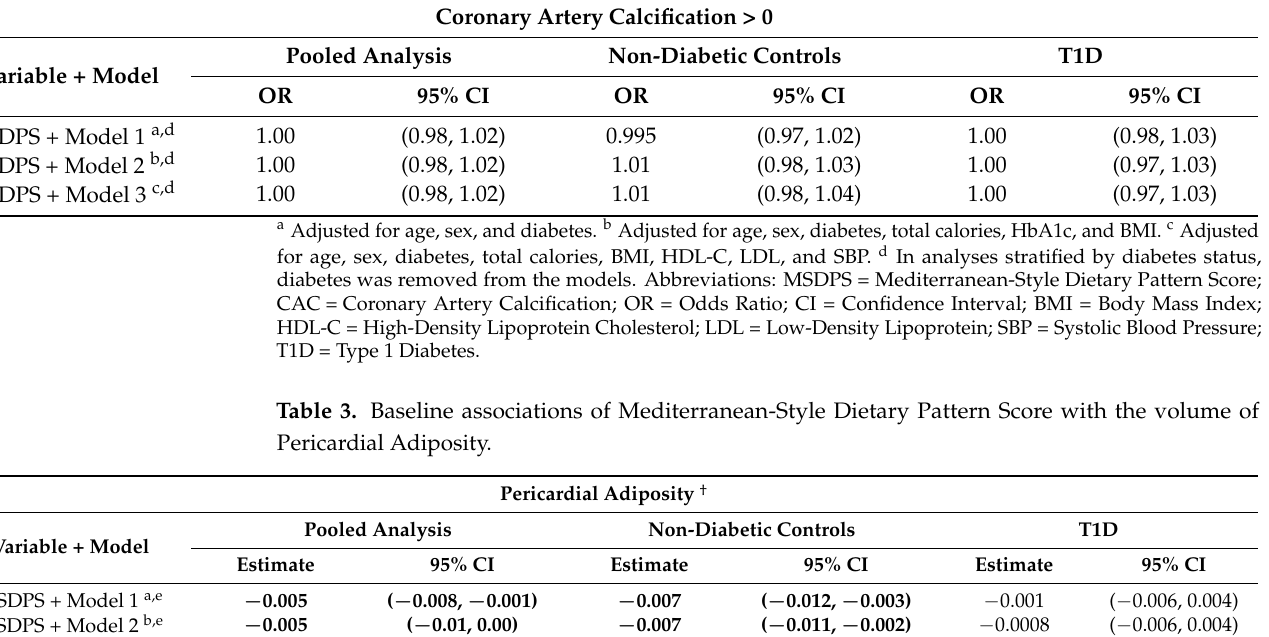
Table 2. Baseline associations of Mediterranean-Style Dietary Pattern Score with the presence of Coronary Artery Calcification.